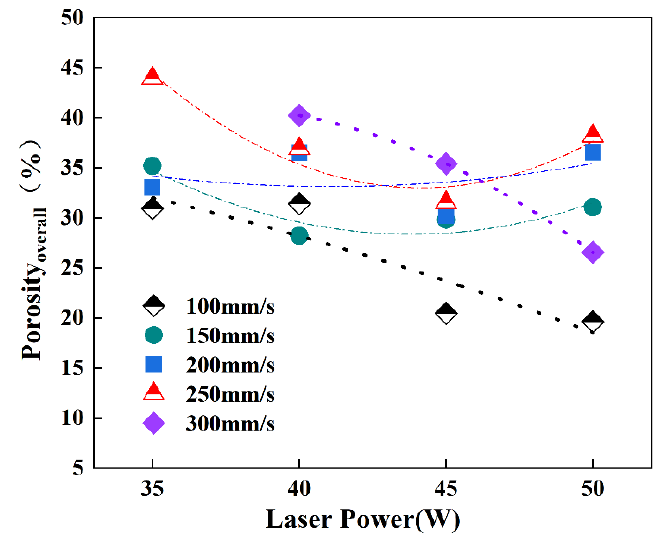
Figure 9. Overall porosities of ISLF samples with different processing parameters.